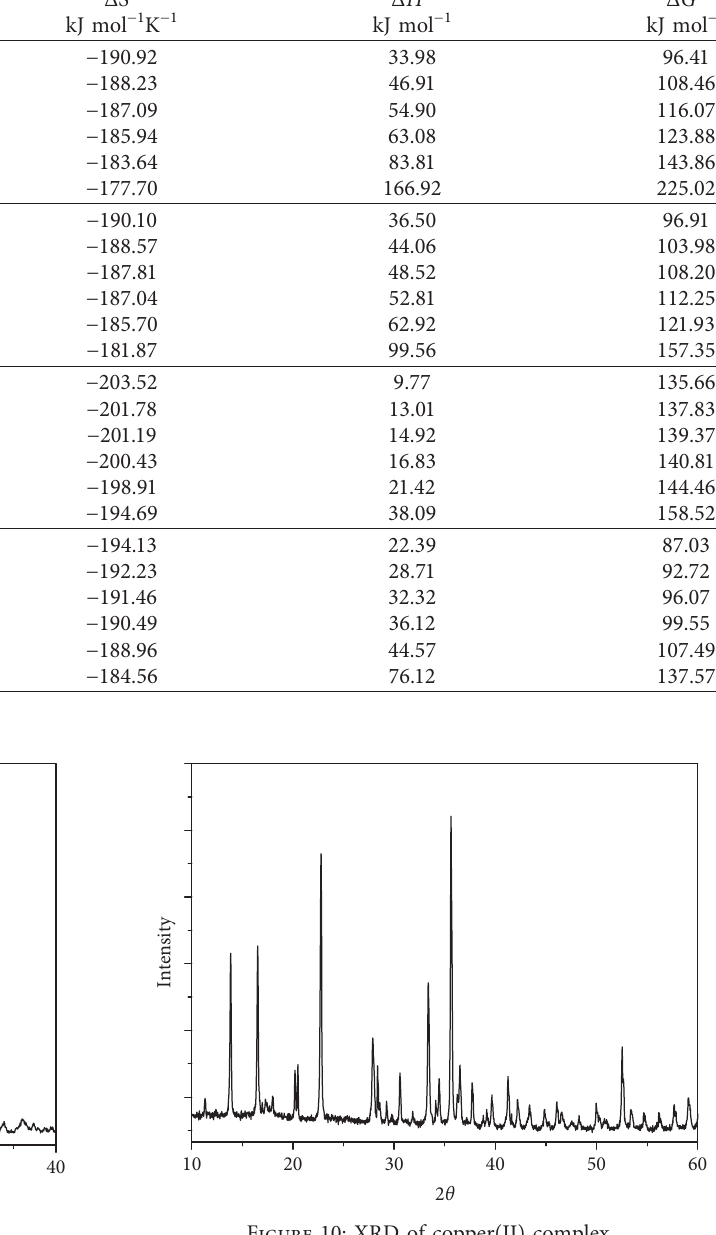
Table 6: Thermodynamic parameters for the thermal decomposition of the compounds. Complex